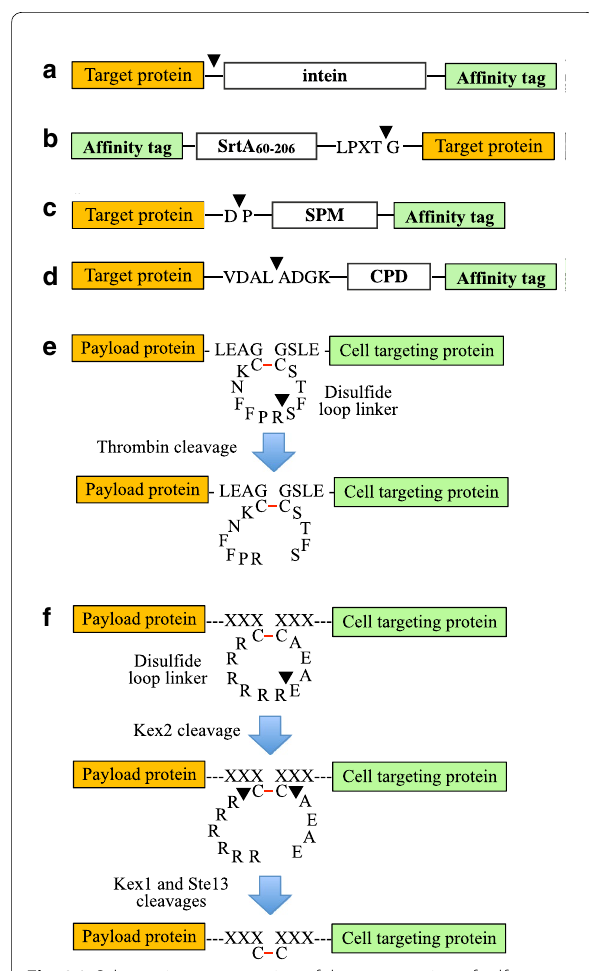
Fig. 26 Schematic representation of the construction of self- cleaving fusion systems. Filled triangle indicates cleavage sites and X stands for any AA. a The construct of the original C-terminal intein fusion in which the target protein is fused to the N-terminus of the CBD-tagged intein. b The SrtA fusion construct that contains an N-terminal affinity-tag, SrtA catalytic core, the LPXTG motif and the target protein. Cleavage at the LPXTG site allows the release of the target protein with an extra N-terminal glycine. c The FrpC fusion construct that consists of the target protein and the affinity-tagged SPM. Cleavage at the Asp–Pro site (the first two AAs of SPM) results in the release of the target protein with an extra aspartate residue at its C-terminus. d The CPD fusion construct in which the affinity-tagged CPD is fused to the C-terminus of the target protein. The VD double residue in the linker sequence comes from the Sal I restriction site used for cloning whereas ALADGK are residues contained within the CPD. e The dithiocyclopeptide linker with one protease-sensitive site. The fusion protein is linked via a dithiocyclopeptide linker containing a thrombin-specific sequence, PRS. The design of dithiocyclopeptide linker was based on the structure of the cyclopeptide, somatostatin, with the replacement of AA residues 8–10, WKT, by a thrombin- specific cleavage sequence, PRS. f The dithiocyclopeptide linker with three secretion signal processing protease-sensitive sites. The fusion protein is linked via a dithiocyclopeptide linker containing Kex1, Kex2 and Ste13-specific cleavage sequences. Kex2 cleaves RR E. Kex1 and ↓ Ste13 remove C-terminal RR and N-terminal EA,